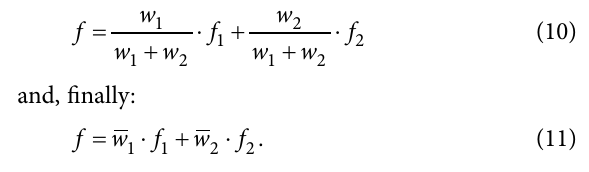
Fig. 2. Two of three cameras inside the